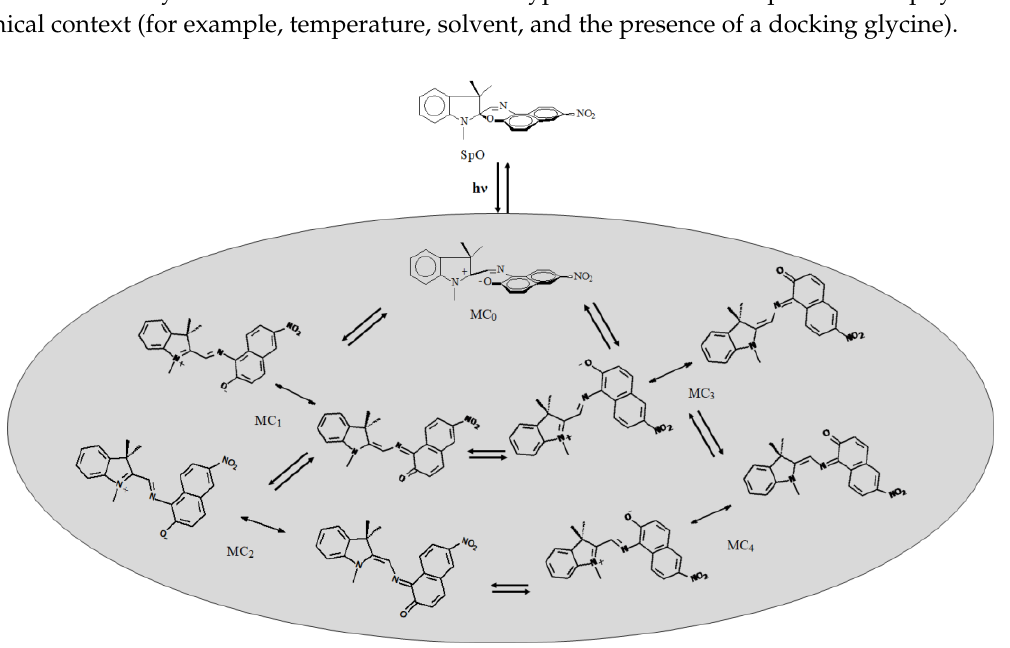
Figure 9. Just of a few of all the possible conformers of a merocyanine (MC i ) produced by irradiation of a spirooxazine (SpO).